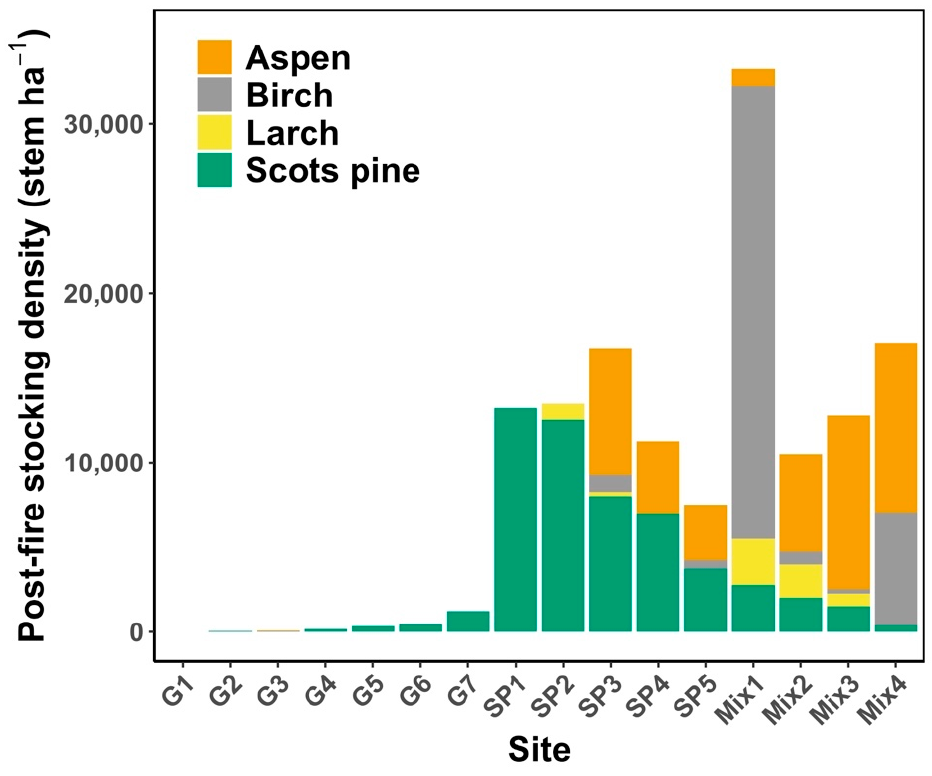
Figure 6. Post-fire stocking density of aspen, birch, larch and Scots pine from all the burnt sites that were undertaking different successional pathways used in the study. Sites: grass (G), Scots pine (SP) a mixture of species (Mix), respectively.